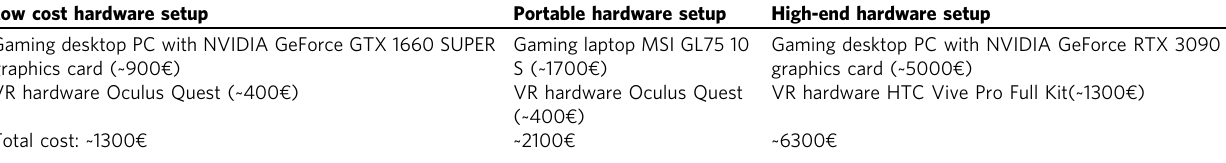
Table 1 Three exemplary computer and VR hardware con fi gurations for running the VRNetzer